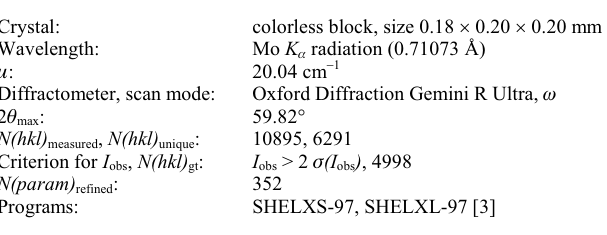
Table 1. Data collection and